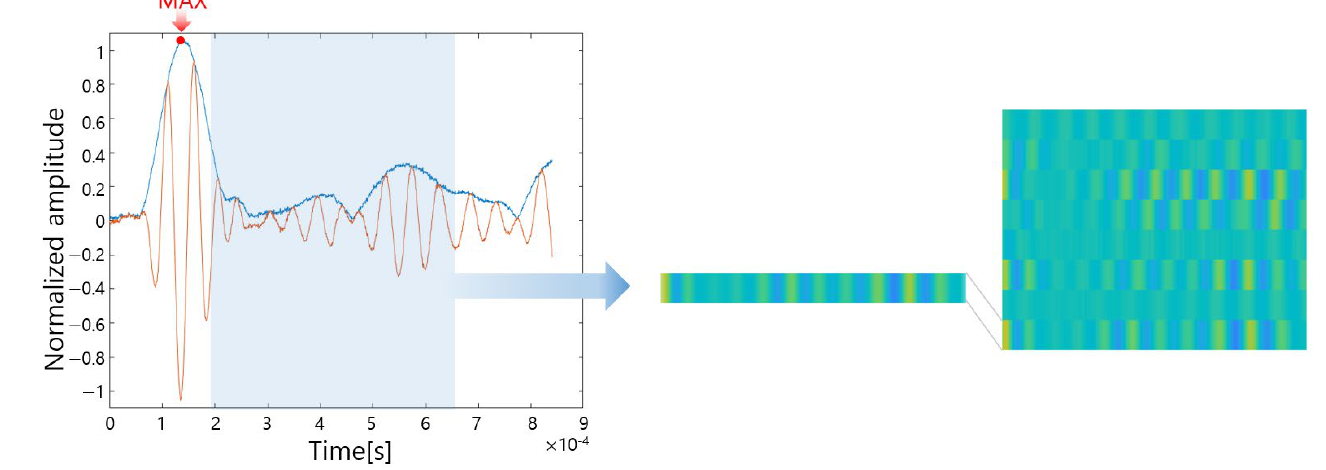
Figure 18. Roughly measured time of the reflective waves from defects and converted training image based on the time interval .